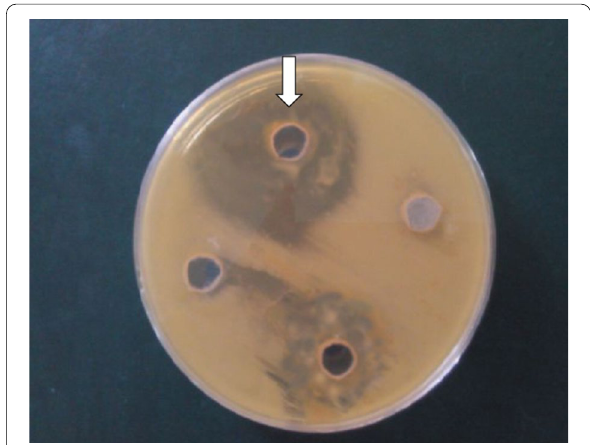
Fig. 9 Antagonistic effect of Candida pelliculosa (arrow) on Campylobacter jejuni at pH